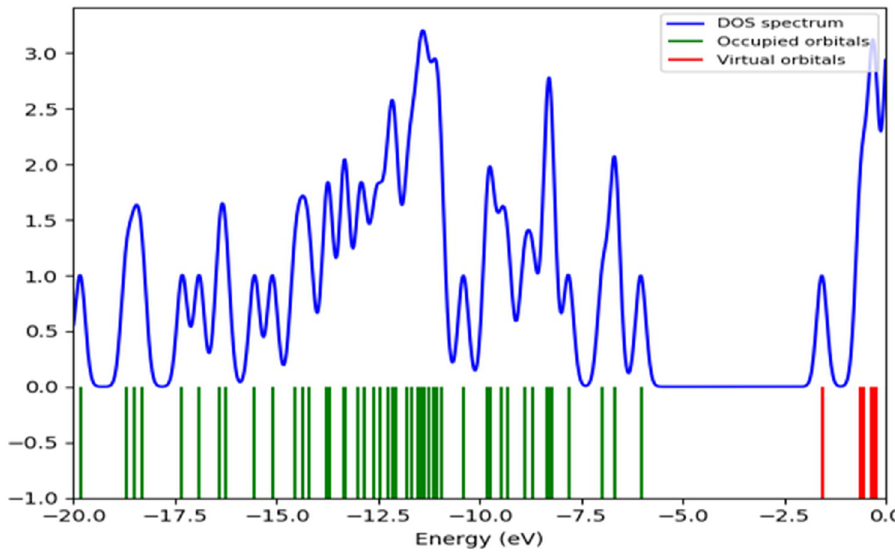
Fig 14. The TDOS spectrum of